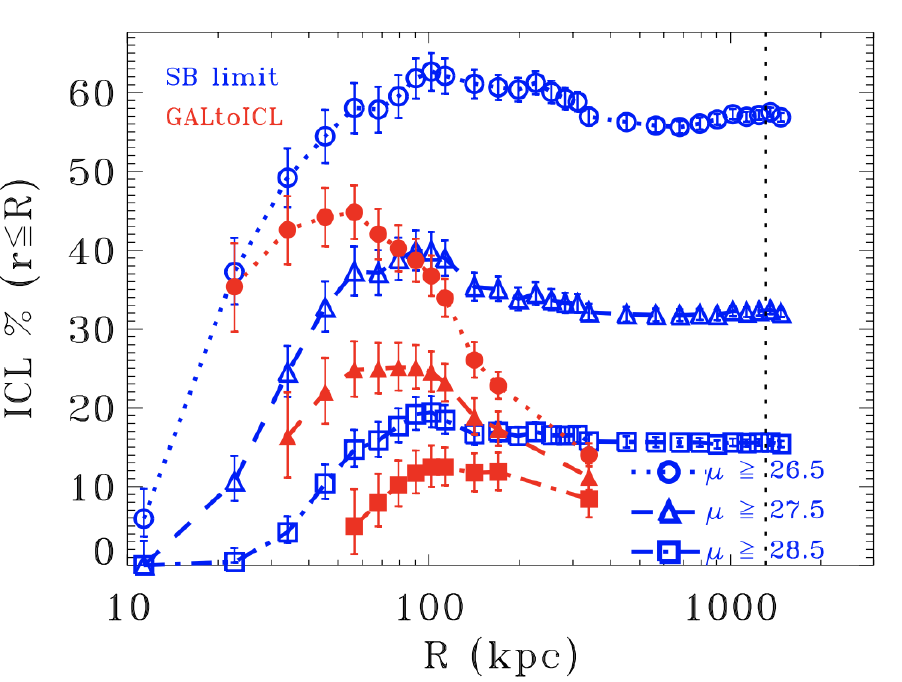
Figure 2. The ICL fraction as a function of distance from the center for different surface brightness cuts and different ICL measurements methods. Blue symbols and lines refer to the standard surface brightness method, while red symbols and lines refer to the method developed in Presotto et al. [5] for masking satellite galaxies. Credit: Presotto et al.